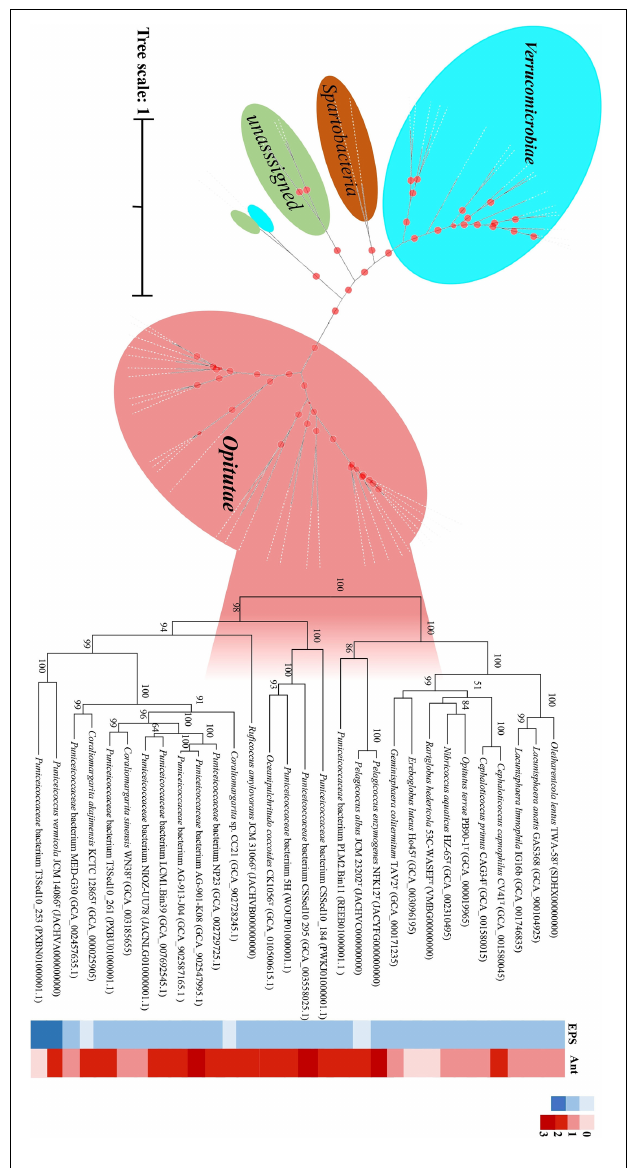
FIGURE 5 | Phylogenetic analysis of the protein sequence computed using all the verrucomicrobial genomes reported in this study by IQ-TREE/FastTree. Desulfocarbo indianensis SCBM T was used as an outgroup to root the tree. The genomes of the exopolysaccharide (EPS)-producing strains are shown in the solid blue grid, and those of the fluoroquinolone-resistant strains are shown in the solid red